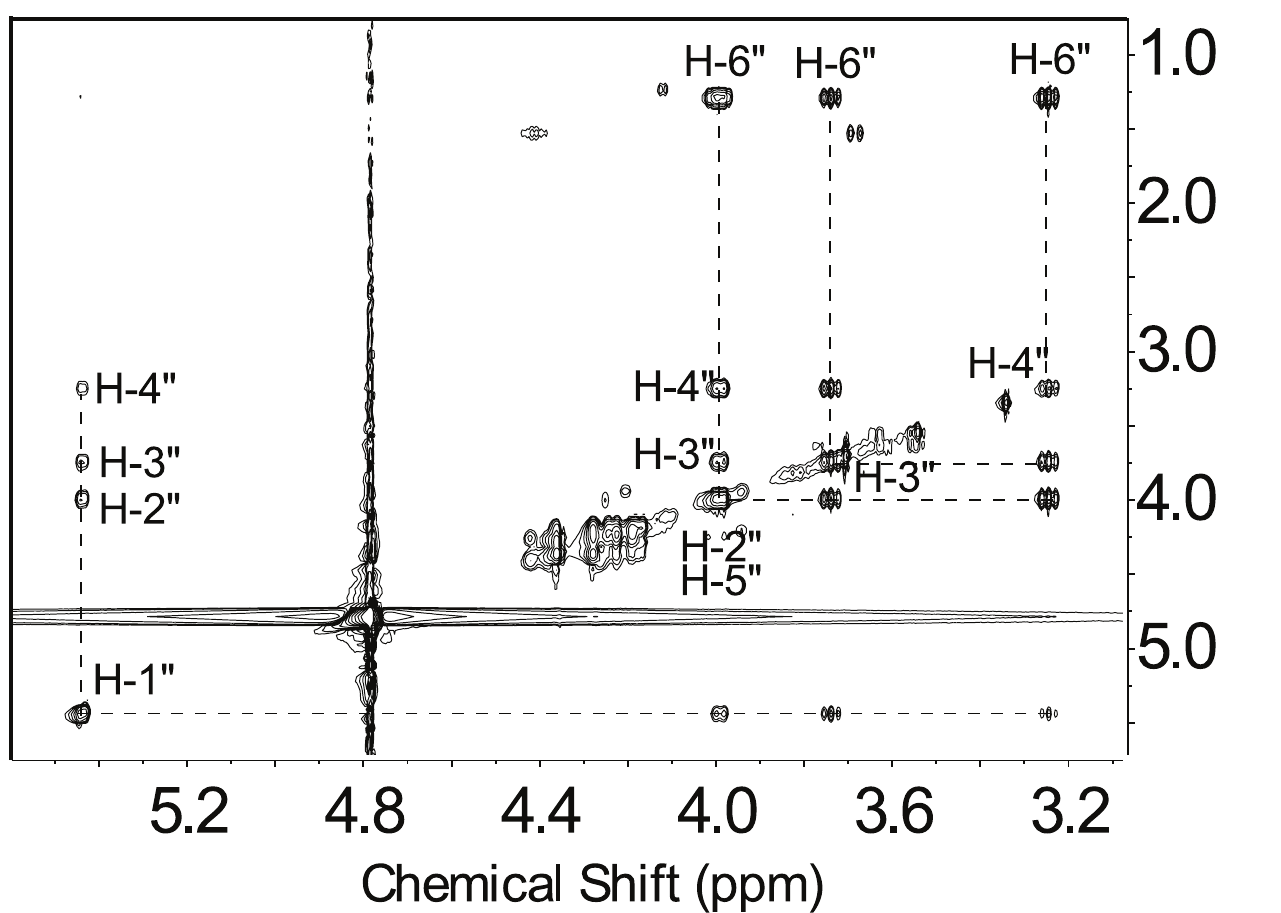
Fig 8. TOCSY spectrum of UDP-QuiNAc shows the coupling among QuiNAc sugar ring